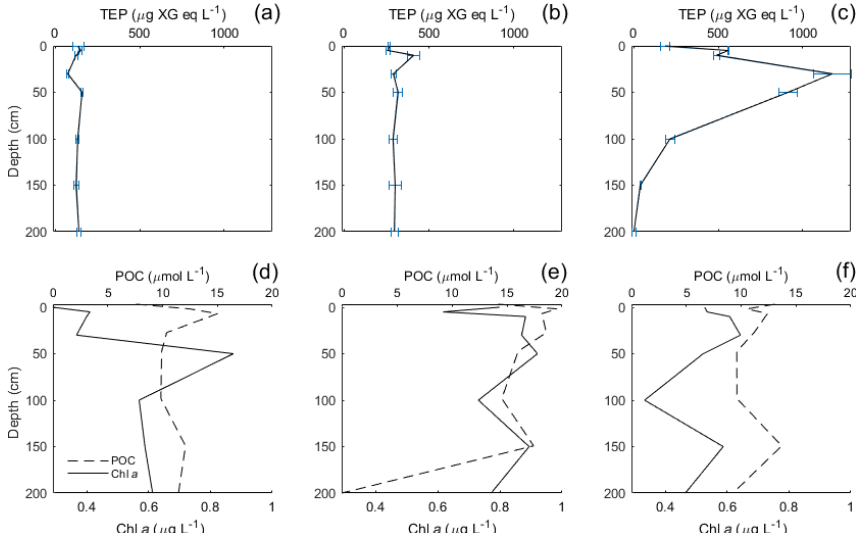
Figure 5. Vertical profiles from stations 3, 7 and 12 during the Norwegian cruise, showing the vertical distribution of TEPs (a, b, c) and Chl a /POC (d, e, f) . Stations were chosen based on the minimum, median and maximum vertical variance of